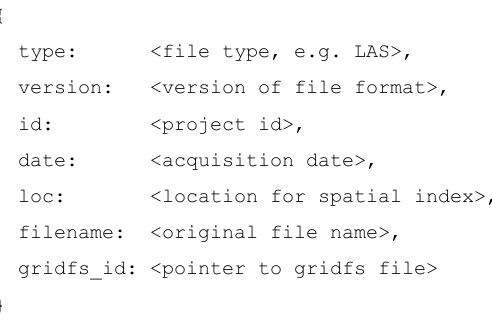
Figure 3: Attributes of a document stored in the collection representing the metadata of a